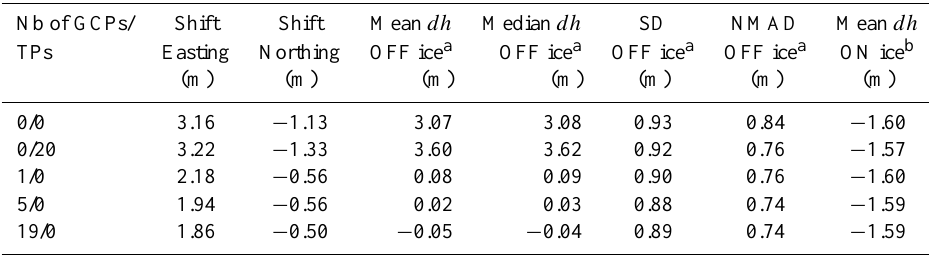
Table 3. Influence of the collection of ground control points (GCPs) and tie point (TPs) on the accuracy of the Pléiades DEMs. Statistics are computed for the elevation differences ( dh ) between the Pléiades and lidar DEMs around and on the Tungnafellsjökull ice cap (Iceland). The Pléiades DEMs are computed using different numbers of GCPs and TPs. The parameter settings used to generate all the DEMs are as follows: DEM detail is low, type of terrain is mountainous, pixel size is 4m, data gaps are not filled. The number of pixels used in these statistics is over 3000000.